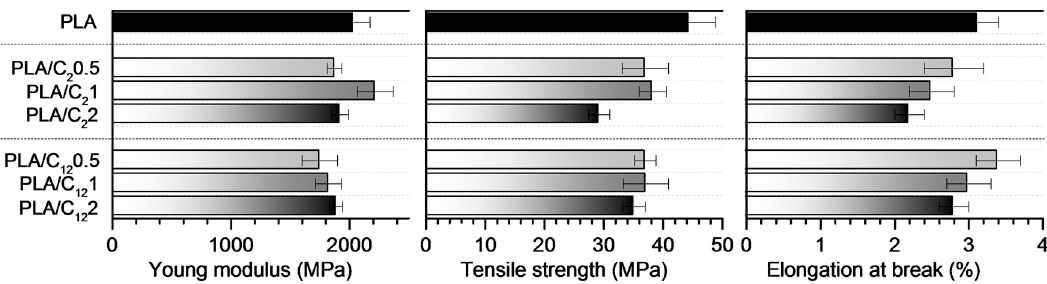
Figure 8. Mechanical properties of PLA films and PLA nanocomposites in terms of Young’s modulus, tensile strength and elongation at break.